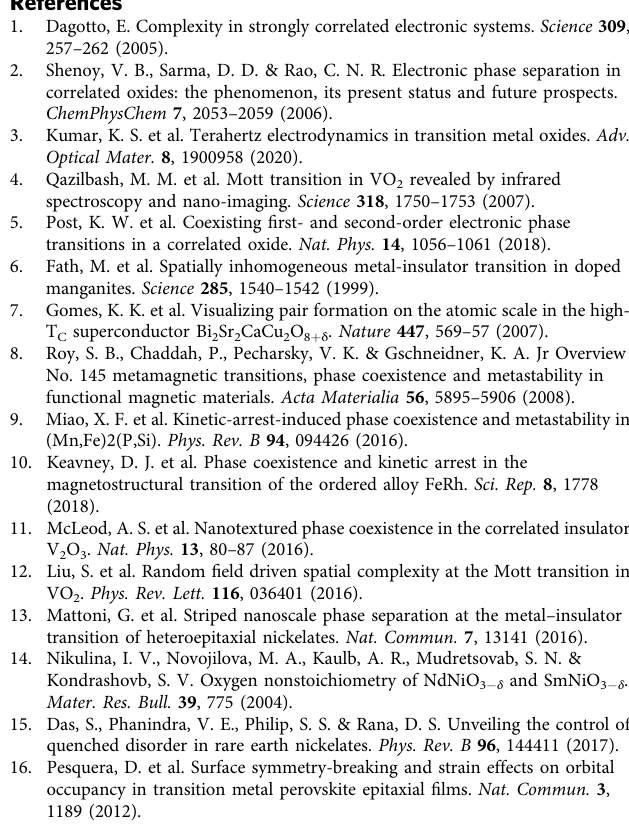
Fig. 1. More details about the spectrometer, its working principle, and measure- ment procedure can be found in ref. 38 . The frequency-dependent THz optical properties were determined in the temperature range of 5 – 300 K. The THz data were collected at different fi xed temperatures by passing the THz waveform fi rst through vacuum, then through the substrate and fi nally through the fi lm deposited on the very same substrate (see Supplementary Fig. 2a). To avoid any phase error, we processed the substrate in the same deposition condition which was to be used for the fi lm growth before taking the measurements for the substrate. After then, fi lm was grown on the same substrate, and the THz data were collected for the fi lm. The spatial dimension of all the fi lms for THz measurement was 10mm ´ 10